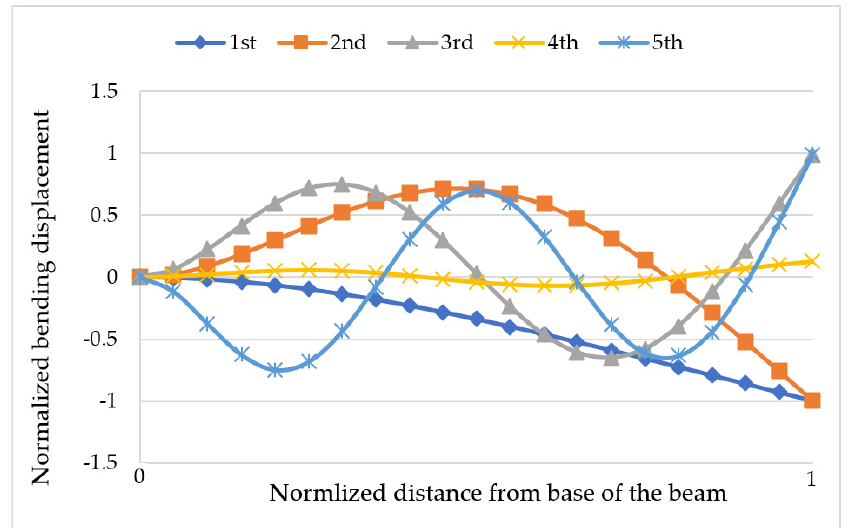
Figure 8. Bending component of the first five mode shapes of the cantilevered, preloaded, three-layer, unidirectional composite beam (Layup 1) obtained using a 20-element LBDFE model, subjected to an axial load of 1.85 MN and end moment of 6.14 MN·m.